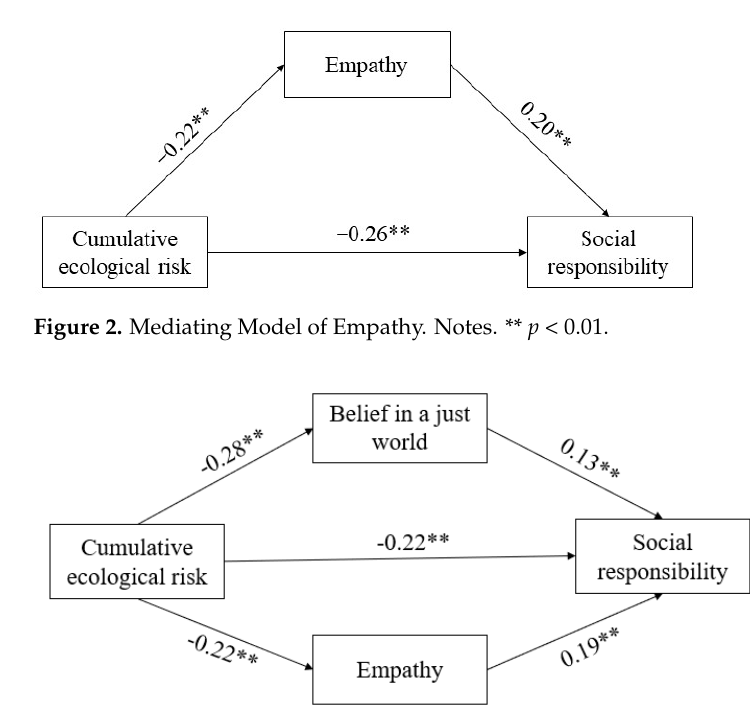
Figure 1. Mediating Model of Belief in a Just World. Notes . ** p < 0.01.